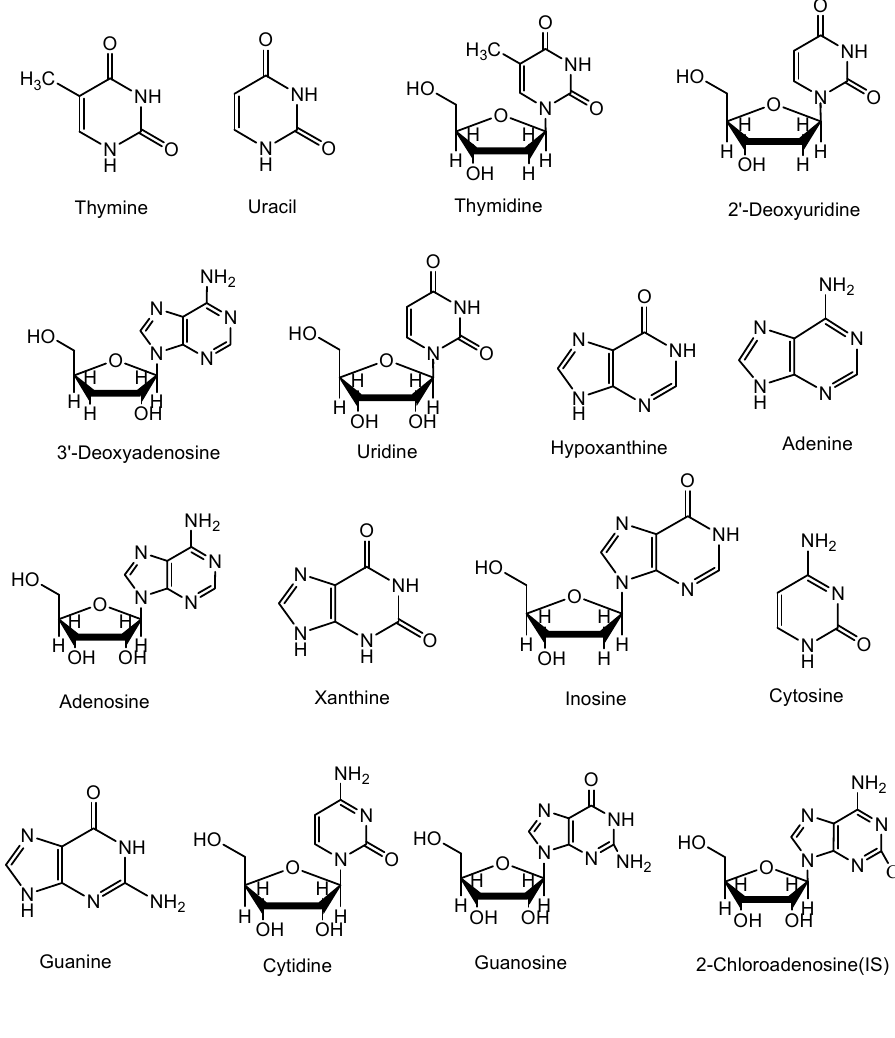
Figure 4. Chemical structures of nucleosides and nucleobases identified in Cordyceps